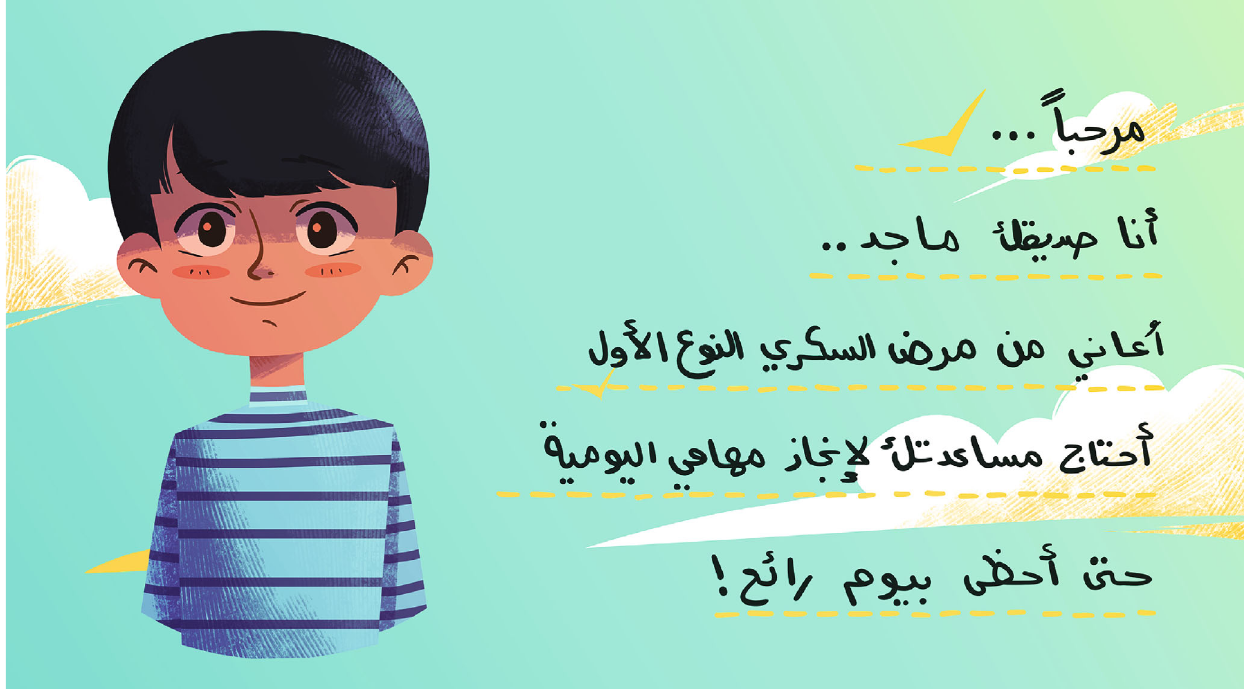
Figure 3: Welcome message screen.